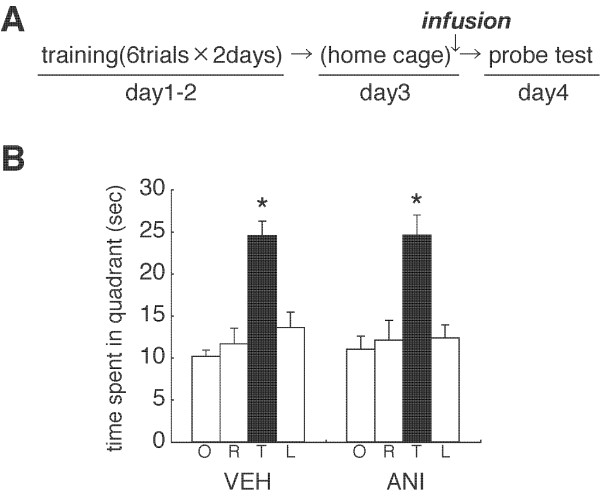
Effect of no re-exposure on the stability of spatial memory. (A) Experimental design. (B) Probe trial at day 4 (VEH, n = 9; ANI, n = 9). *P < 0.05, time spent in the TQ vs. time spent in the other quadrants by post hoc Newman-Keuls test after significant one-way ANOVA. Error bars are SEM. Time spent (s) in target (T), adjacent left (L), adjacent right (R), and opposite (O) quadrants during the probe trial is shown.